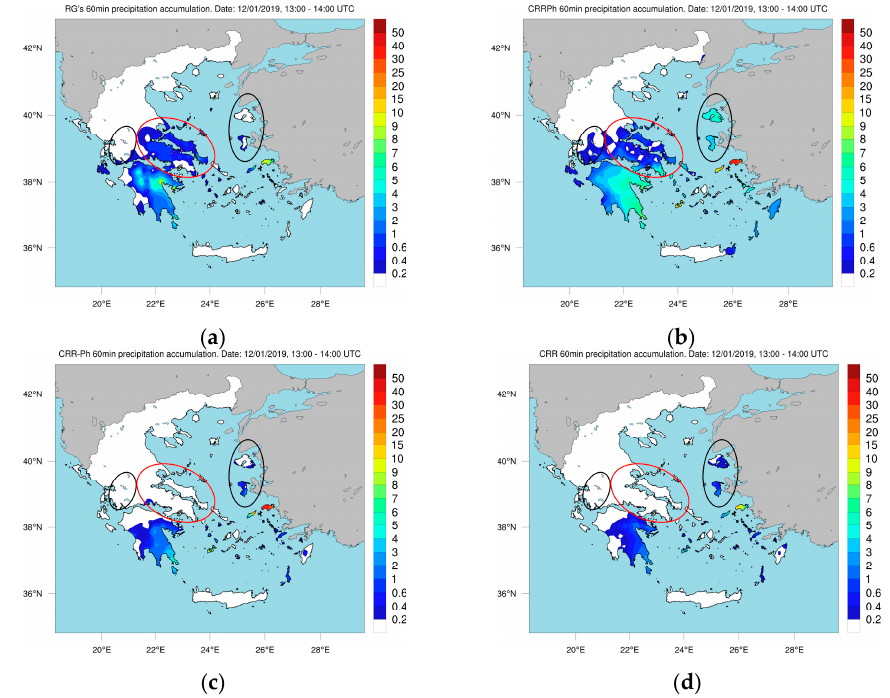
Figure 2. 07:00–08:00 UTC precipitation accumulations (in mm) for 3 January 2019, derived from ( a ) RG observations, ( b ) CRRPh v2021 estimations, ( c ) CRR-Ph v2018 estimations, and ( d ) CRR v2021 estimations.